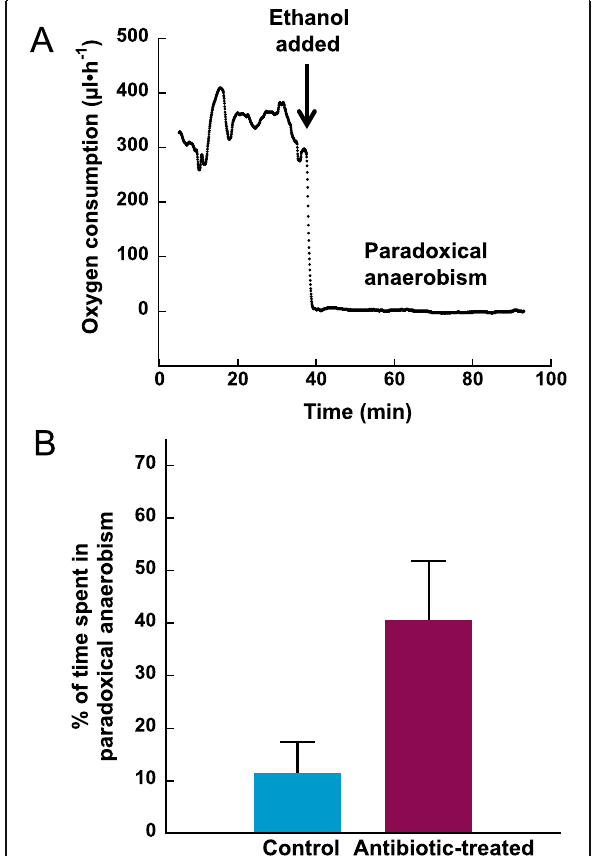
Fig. 1 Measurements of paradoxical anaerobism. a Demonstration of induction of paradoxical anaerobism using 1% ethanol (vol/vol). Pupfish ( n =12 antibiotic-treated pupfish and 12 control pupfish) were placed in the metabolic chamber and oxygen consumption was monitored. At the time indicated by the arrow, ethanol was added to a final concentration of 1% (vol/vol). In this example, an antibiotic- treated pupfish immediately entered paradoxical anaerobism and remained in that metabolic state for the duration of the experiment. b Following addition of ethanol, pupfish oxygen consumption was monitored for ~1h. Data are means ± SE of the % of that time which was spent with negligible oxygen consumption. Values are significantly different (Welch ’ s t-test, p